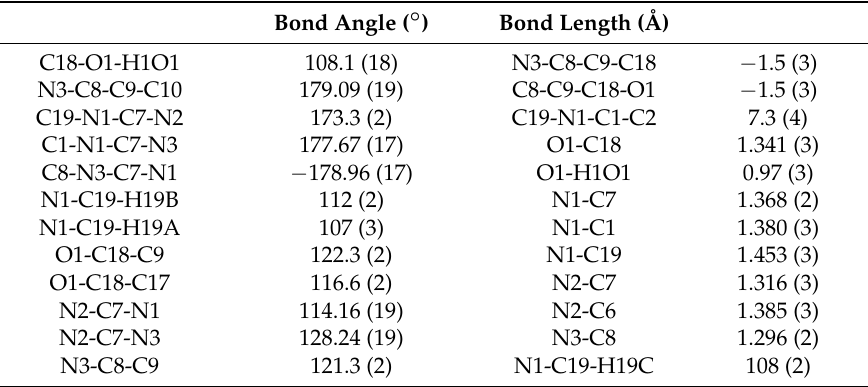
Table 2. Selected bond angle (°) and bond length (Å ).